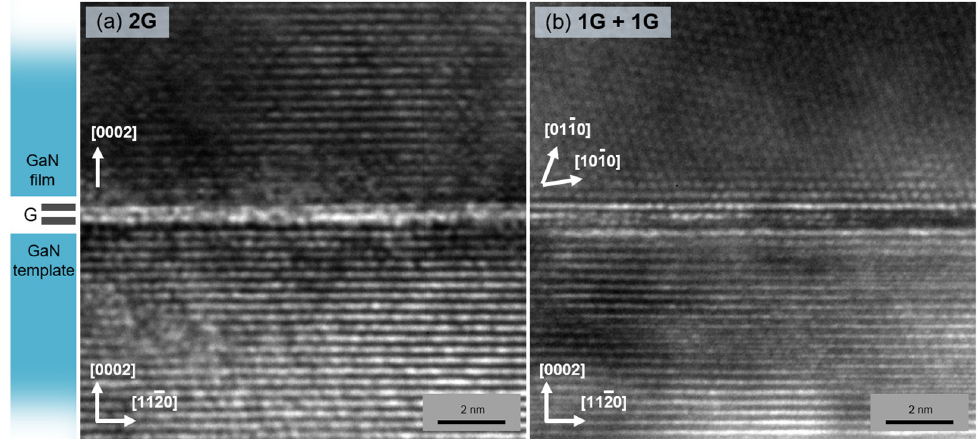
Figure 5. TEM images of GaN film grown on bilayer ( a ) and double-stack ( b ) graphene interlayers. The determined GaN directions are indicated for both the template and the epilayer.